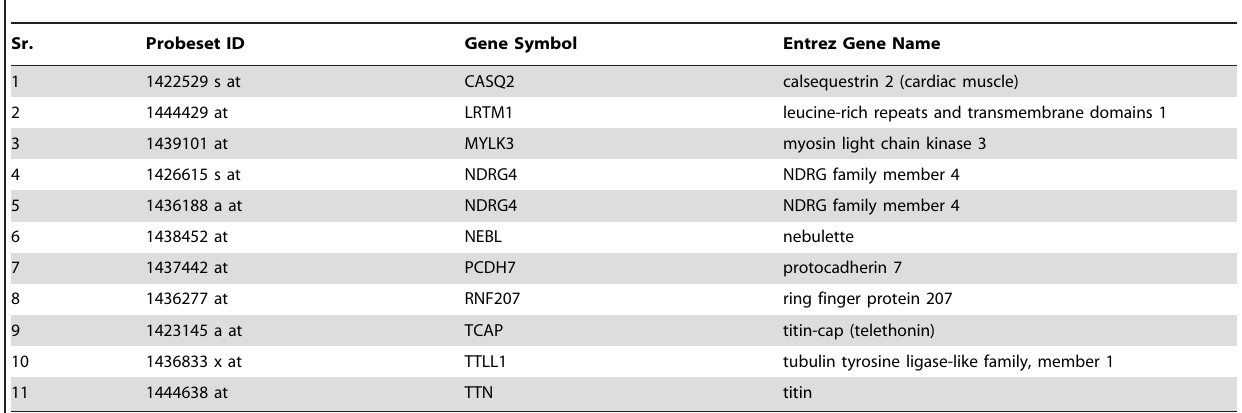
Table 11. Heart 1 heart 4 cluster 3.